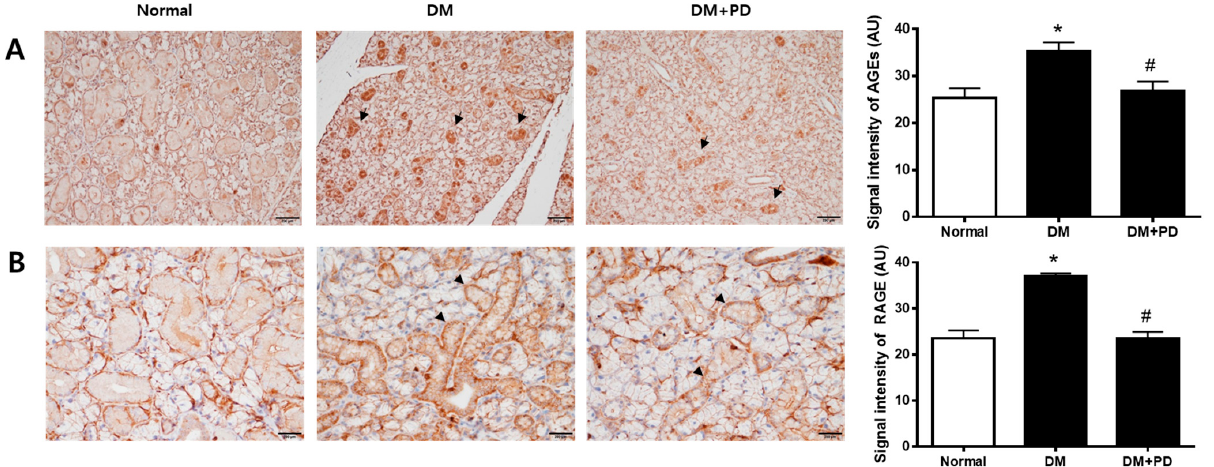
Figure 4. Effect of polydatin on the expression of AGEs and RAGE in submandibular glands. ( A ) Immunohistochemical staining for AGEs. Quantification of the AGEs signal intensity. Arrows indicate AGEs positively stained cells. ( B ) Immunohistochemical staining for RAGE. Quantification of the RAGE signal intensity. Arrowheads indicate RAGE positively stained cells. Data are presented as the mean ± standard deviation ( n = 7). * p < 0.05 vs. Normal group; # p < 0.05 vs. DM group.